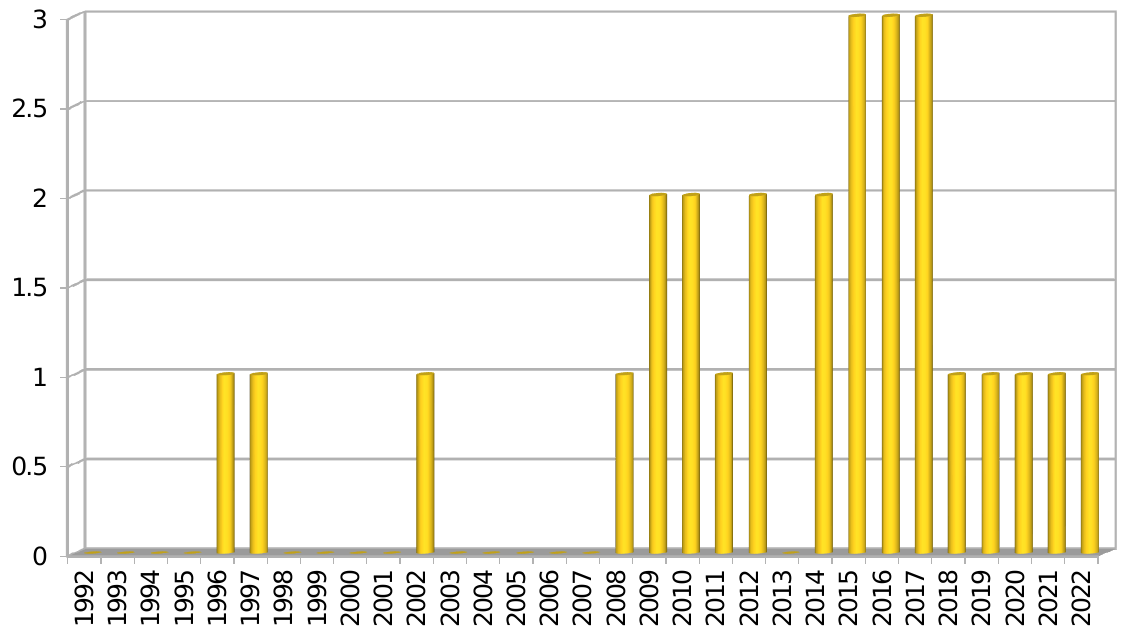
Figure 1. Timeline histogram of all articles on asynclitism published in the last 30 years. As discussed in the paper, the attention of the scientific community toward asynclitism has increased mostly in the last 20 years, although the number of all the papers available in the literature on this topic is still unsatisfactory to definitely standardize asynclitism diagnosis and management. Table 1. All the articles available in literature in the last 30 years on asynclitism with a short de- scription of their main characteristics and relevant results. Abbreviations: 4CW, four-chamber view; AoP, angle of progression; ASC, asynclitism; CPD, cephalopelvic disproportion; CS, cesarean section; DE, digital vaginal examination; FP, forceps; HD, head direction; HPD, head progression distance; HR, head rotation; IPU, intrapartum ultrasound; US, ultrasound; LNA, labor neuraxial analgesia; N°, number of papers mentioned in the review; OSA, occiput – spine angle; PAA, pubic arch angle; POPP, persistent occiput posterior position; PS, prospective cross-sectional study; RCT, randomized control trial; TA, transabdominal suprapubic ultrasound scan; TL, translabial ultra- sound scan; TP, transverse position; TTC, tears of tentorium cerebellum; VE, vacuum extractor; YR, year of publication; vs., versus.